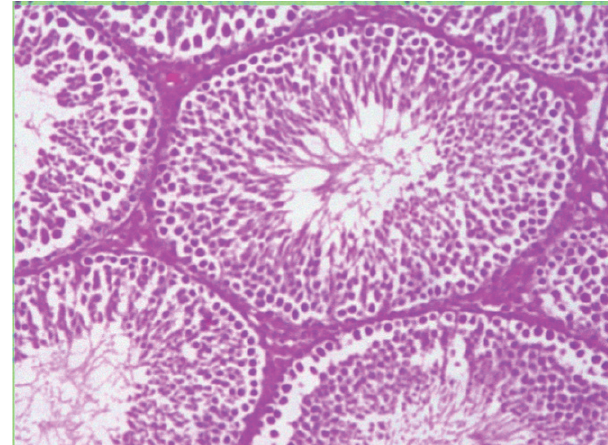
Figure 4 - Magnified photograph of a section of testis after the protective treatment with vitamin E for two weeks showing remarkable regenerative features. H&E 6